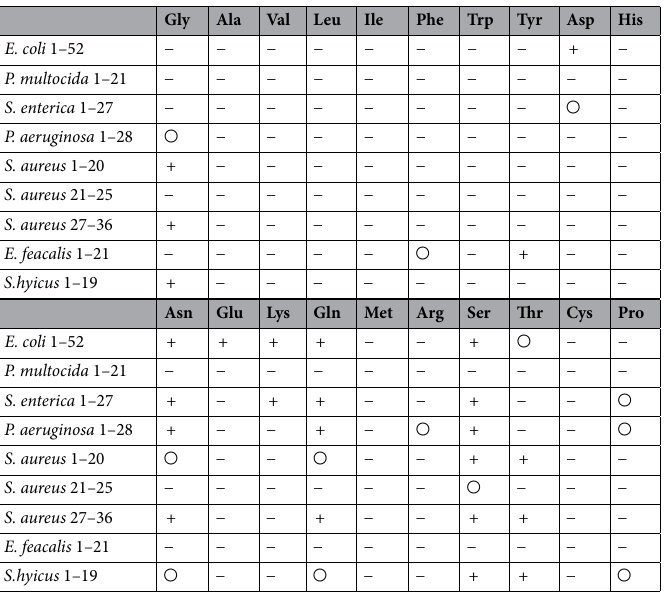
Table 1. Average consumption of AAs. The average AA consumption profiles of E. coli (n = 52), P. multocida (n = 21), S. enterica (n = 27), P. aeruginosa (n = 28), S. aureus (n = 20), cattle S. aureus (n = 5), MRSA (n = 10), E. faecalis (n = 21), and S. hyicus (n = 19). − indicates the average consumption is less than 50%; ○ indicates the average consumption is from 50 to 75%; + indicates the average consumption is more than